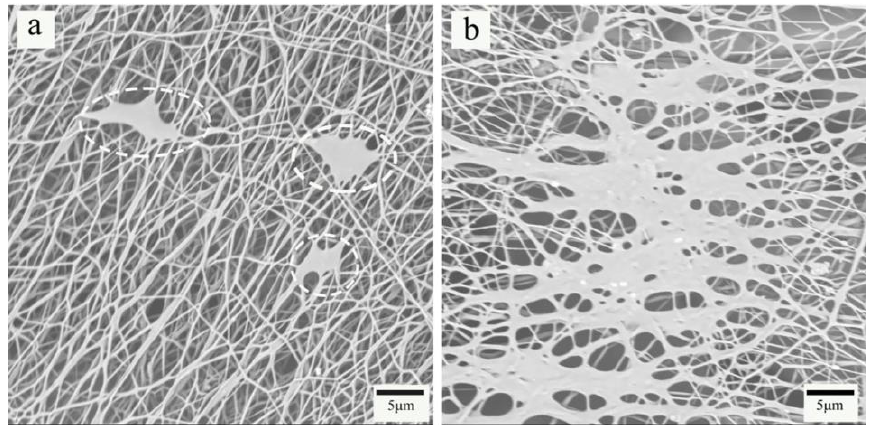
Figure 4. Agglomeration of ( a ) PP/PVA/ZIF-8-3.75% and ( b ) PP/PVA/ZIF-8-5%.